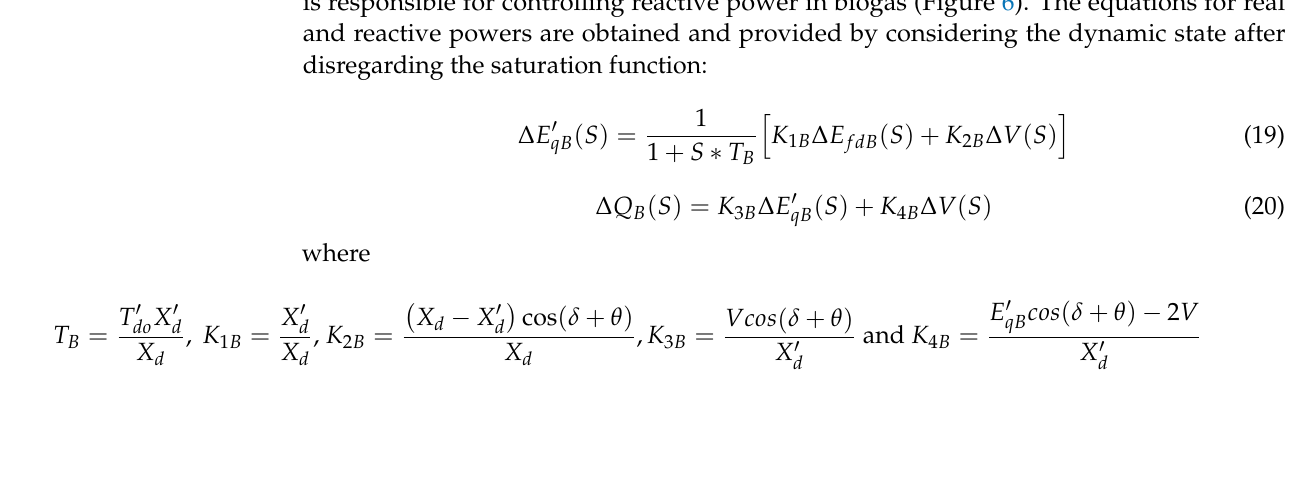
Figure 6. ( a ) Block diagram of real power generation of biogas and ( b ) block diagram of reactive power generation of biogas.